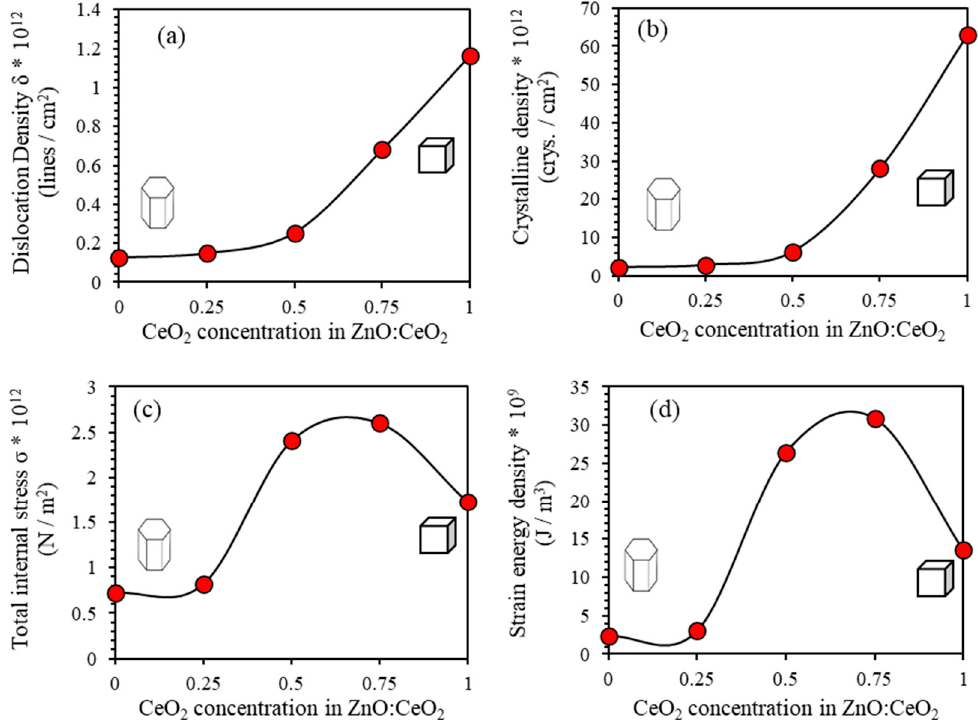
Figure 4. ( a ) Dislocation density, ( b ) crystalline density, ( c ) total internal stress and ( d ) strain energy density of ZnO:CeO 2 mixed oxides thin films as a function of CeO 2 concentration.